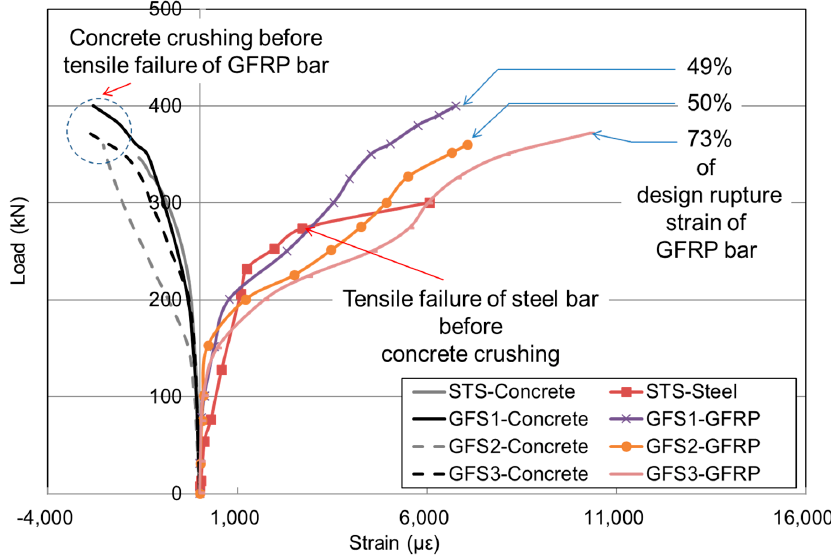
Figure 7. Load and strain relationship of the STS and GFS specimens.